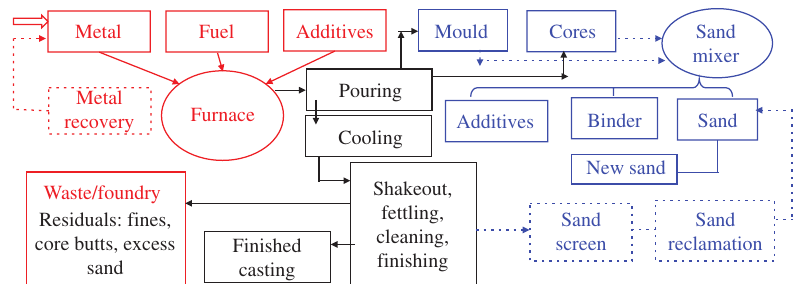
Figure 1: Metal casting procedure in the